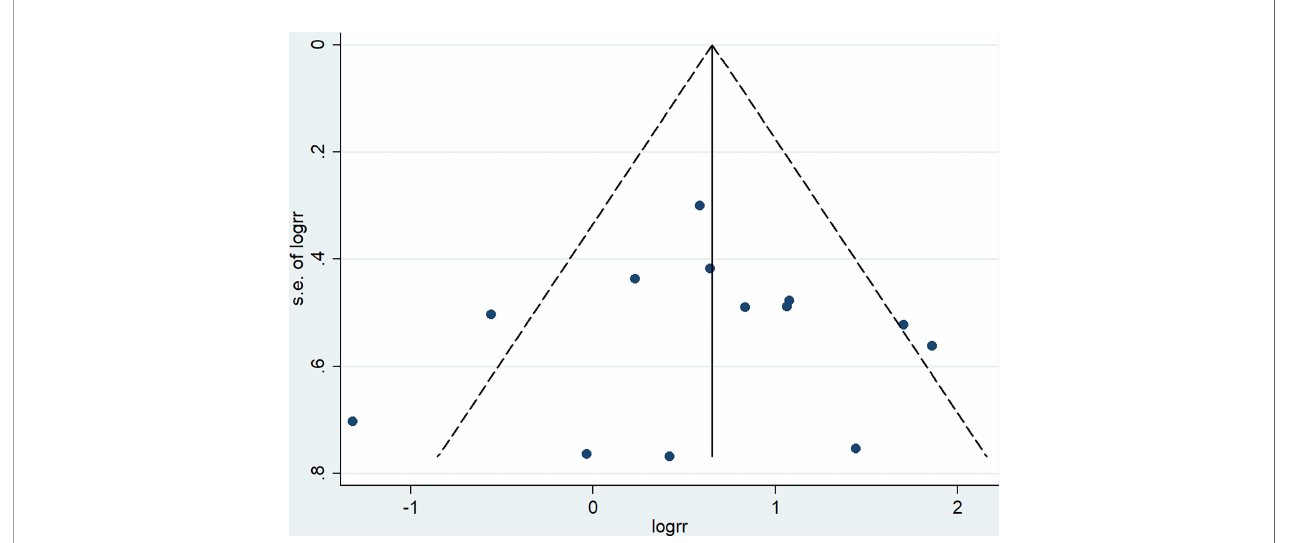
FIGURE 4 | Funnel plot of studies included in meta-analysis of secondary local recurrence rate (SLRR).